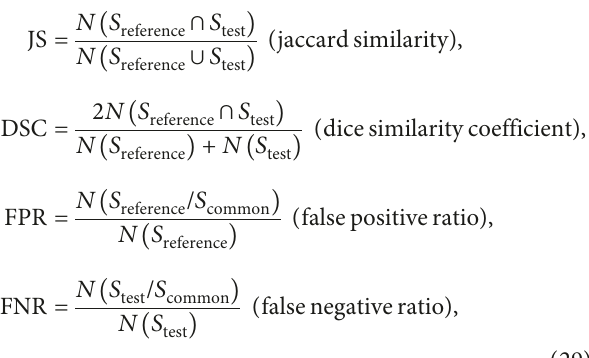
N N 4 system; (b) 8 system; (c) 16